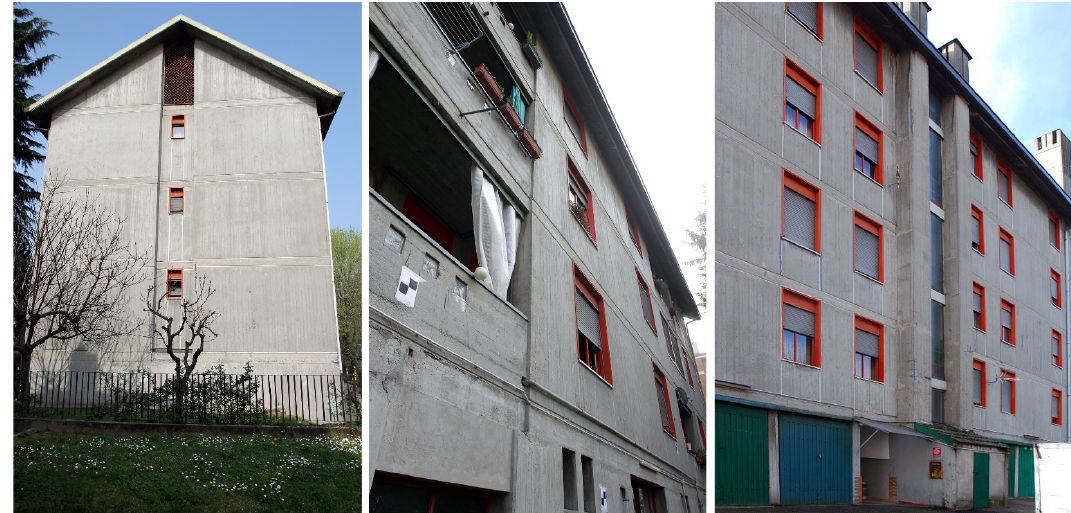
Figure 3. Existing façades of the Italian demo building.